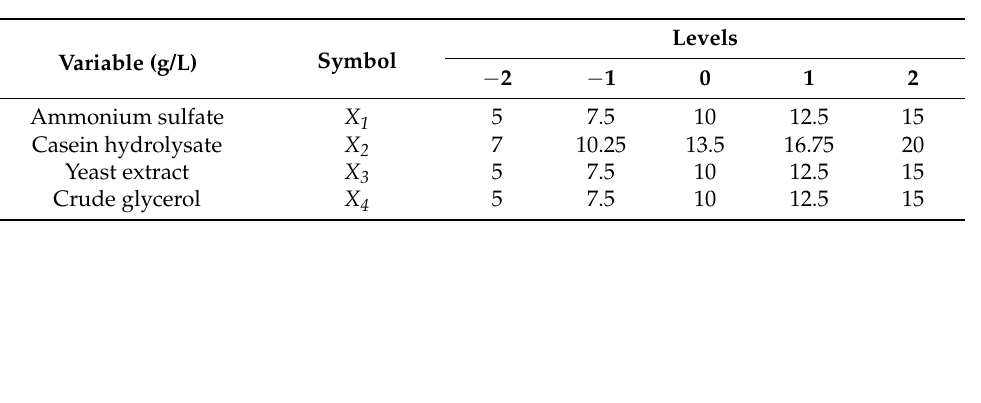
Table 1. Each level of variable for medium components using central composite rotatable design